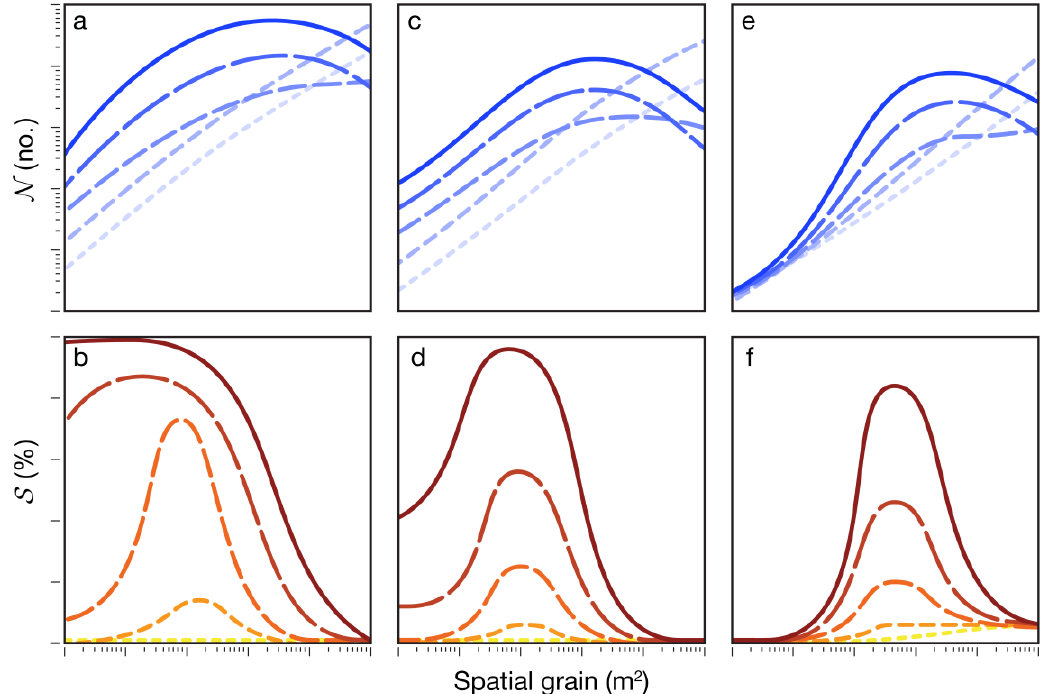
Figure 2. Magnitude of dispersal, N , and disease severity, S , for simulated epidemics in landscapes where the spatial grain (cell dimensions, m 2 ) is systematically increased, under three landscape scenarios (across columns): ( a , b ) an aggregated and abundant host distribution; ( c , d ) a randomly distributed and abundant host distribution; and ( e , f ) a randomly distributed and sparse host distribution. The curves represent different stages (disease assessment intervals) of an epidemic, with dash size and colour intensity increasing with time after inoculation. It should be noted that the same qualitative relationships emerged under different parameterizations of the model, provided the axes and epidemic duration were scaled appropriately; we therefore do not provide values for N , and S